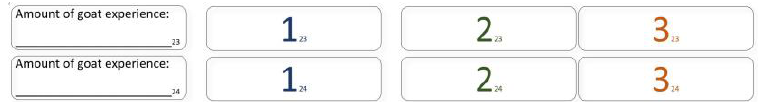
Figure 2. Rankings were printed onto small address labels and included a numerical identifier that allowed the research team to allocate simple demographic information to each ranking while keeping the data anonymous.